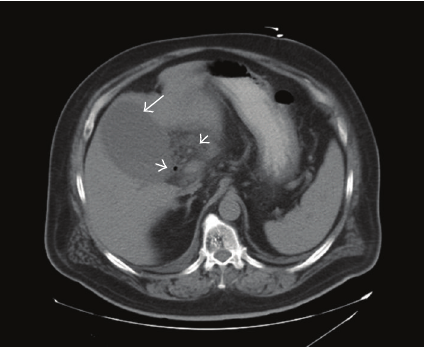
Figure 2: Computed tomography of the abdomen with oral contrast showing the gallbladder markedly distended (long arrow). Air bubbles project over the region of gallbladder neck are seen, suggestive of infection with gas-producing organism (short